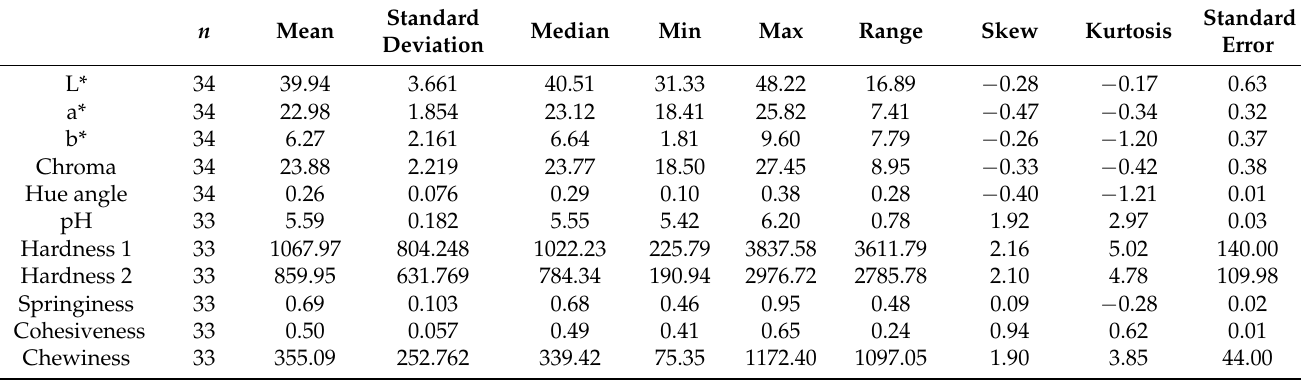
Table 2. Descriptive statistics of the meat quality parameters.